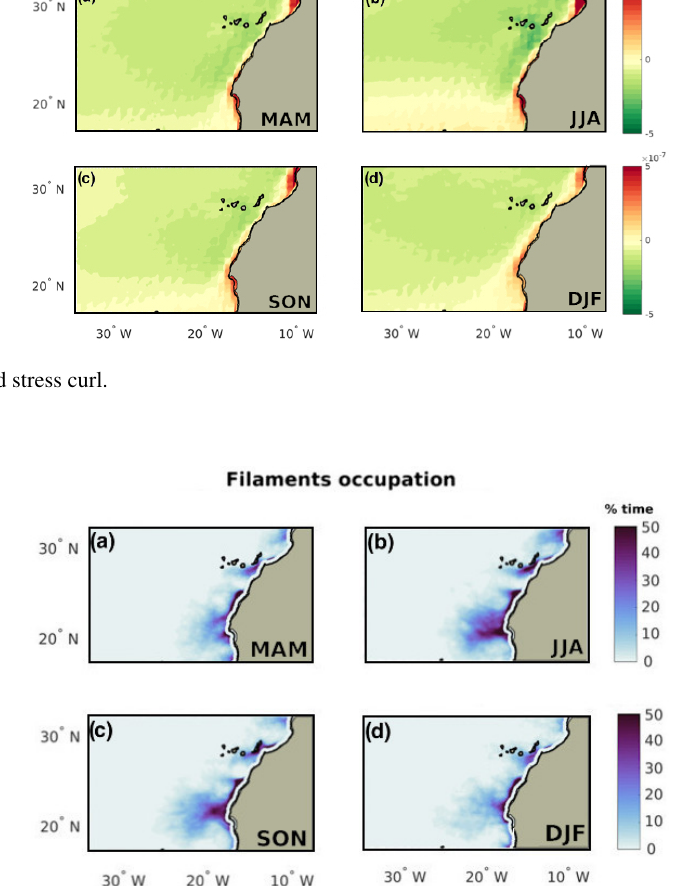
Figure B6. Filament occupation by season. The first 50km from the northwestern African coast have been shaded as, by definition, filaments always cover this range of distances.